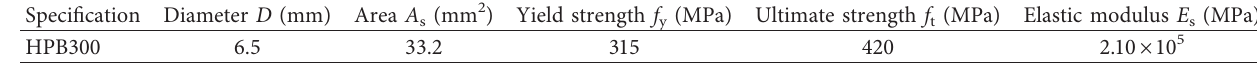
Table 1: Mechanical performance indexes of steel bar.